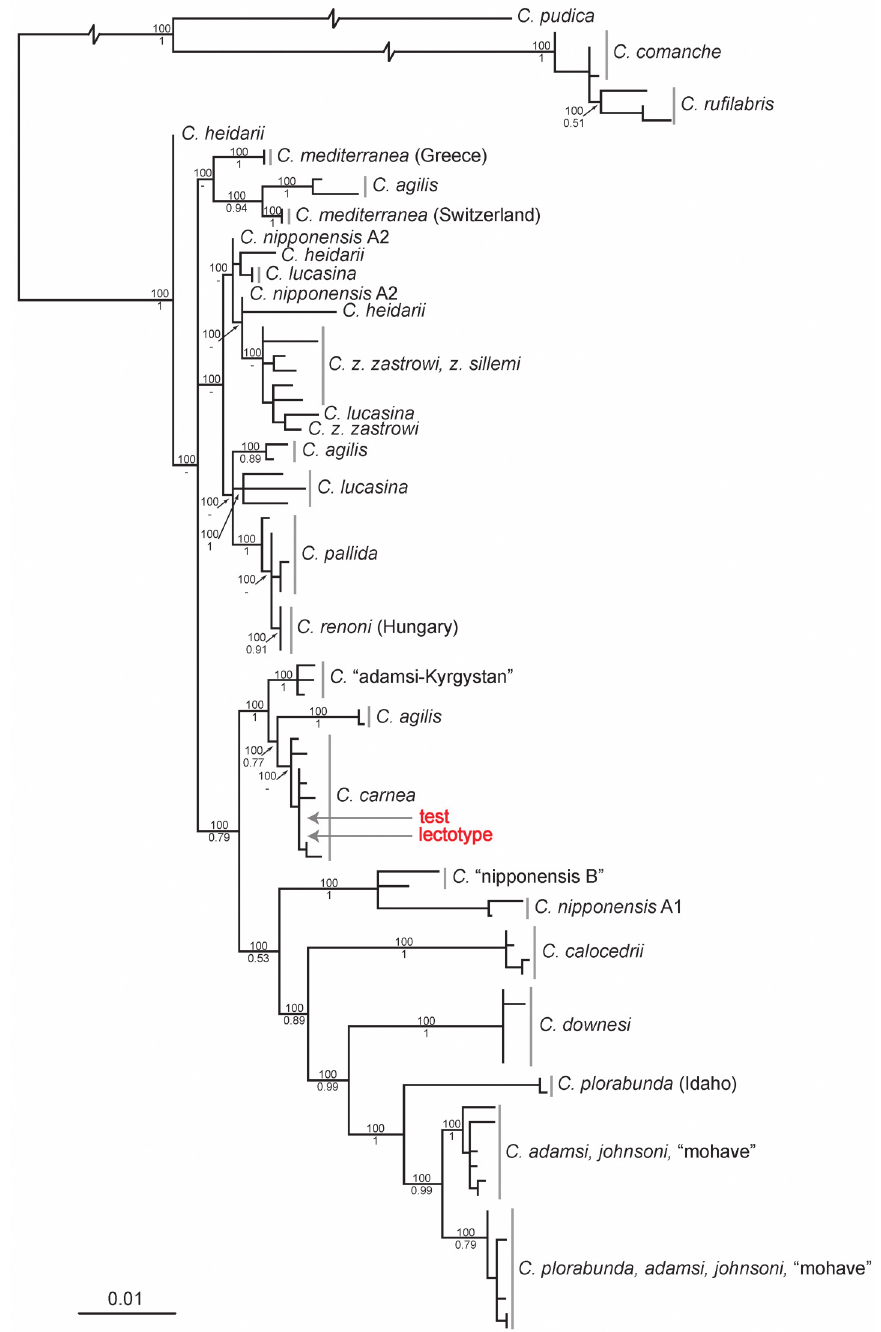
Fig 3. Maximum Likelihood phylogram of the cryptic species of the Chrysoperla carnea -group. Phylogram is based on analysis of 1226 bp of COI sequence. Numbers at the branch points are bootstrap support (above) and Bayesian posterior probabilities (below); branch lengths are proportional to the number of substitutions per site except where indicated. Positions of the test and lectotype specimens in the phylogram are shown in